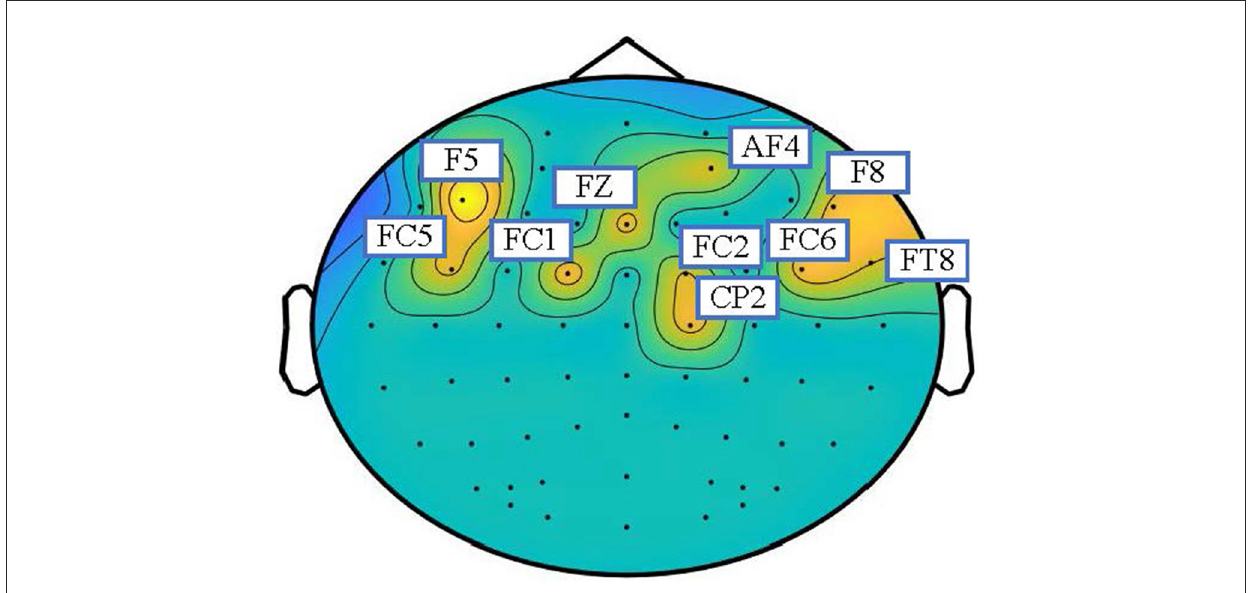
FIGURE3 Topographic map of adjacency matrices on SEED datasets. The weighted electrodes are mainly distributed in the frontal and parietal